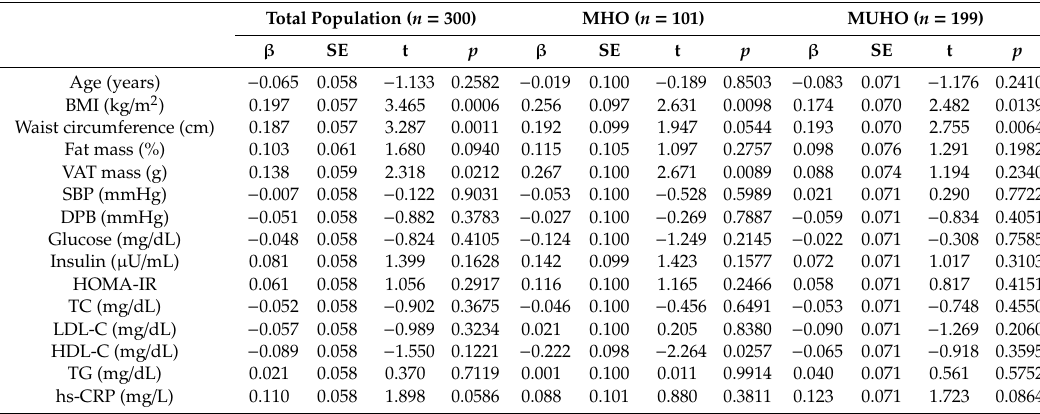
Table 4. Univariate regression analysis assessing the relationship between serum lactoferrin concentrations (ng / mL) and selected